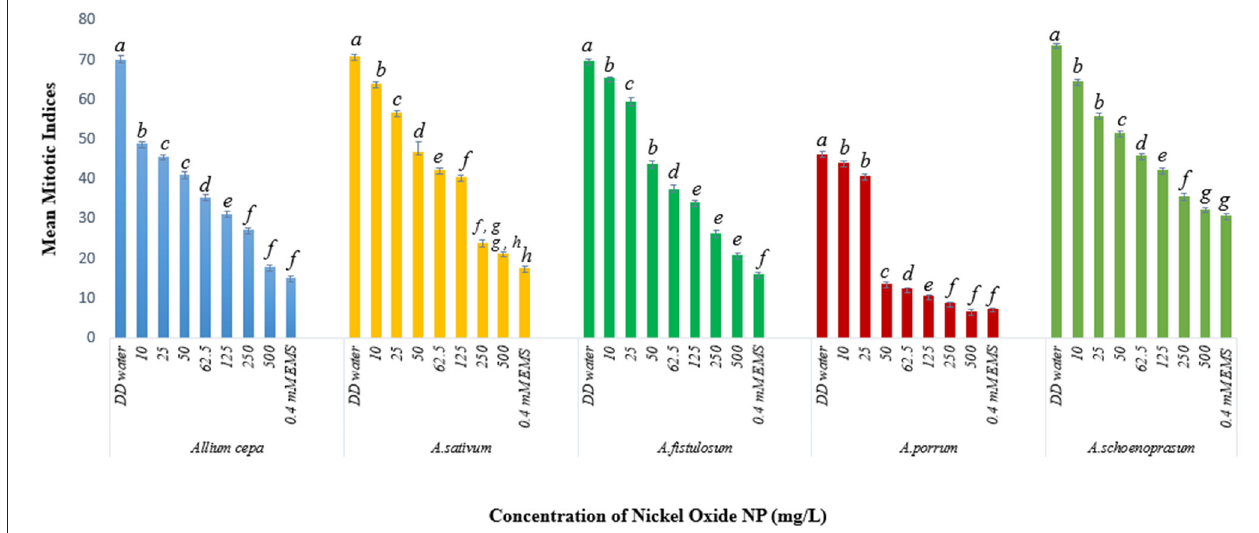
FIGURE 4 | Effect of NiO-NP on mitotic indices in the five species of Allium sp. ( p < 0.05).